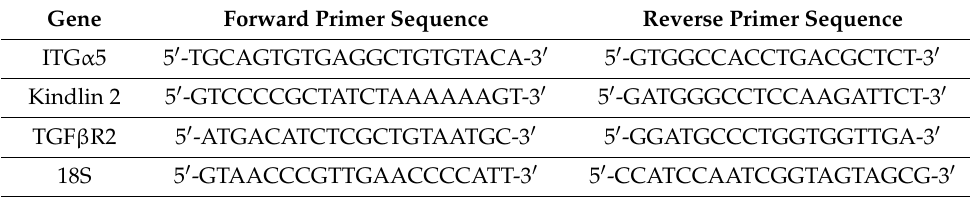
Table 1. Primers used for the gene expression using qRTPCR